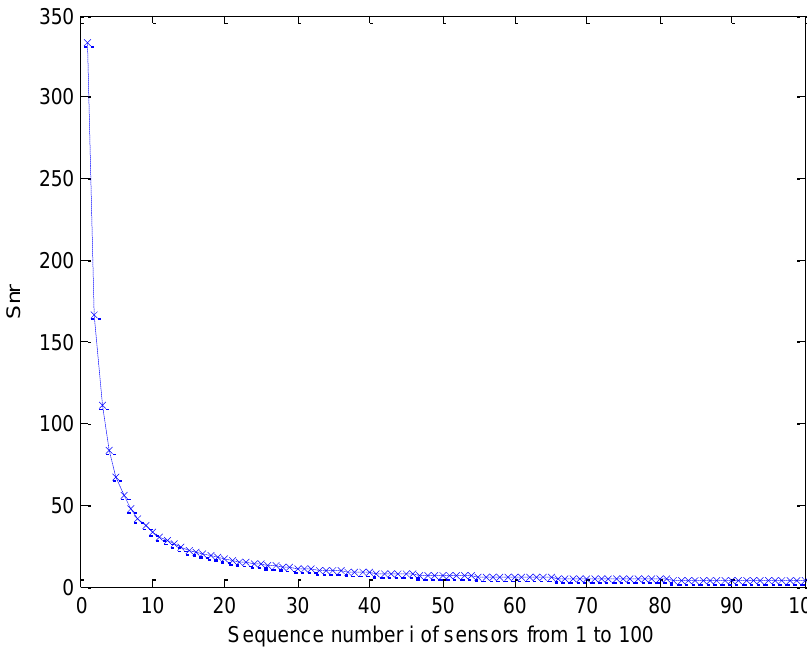
Electronics 2022 , 11 , x FOR PEER REVIEW Figure 2. The SNR evaluation results of the target from sensor 1 to sensor 100.